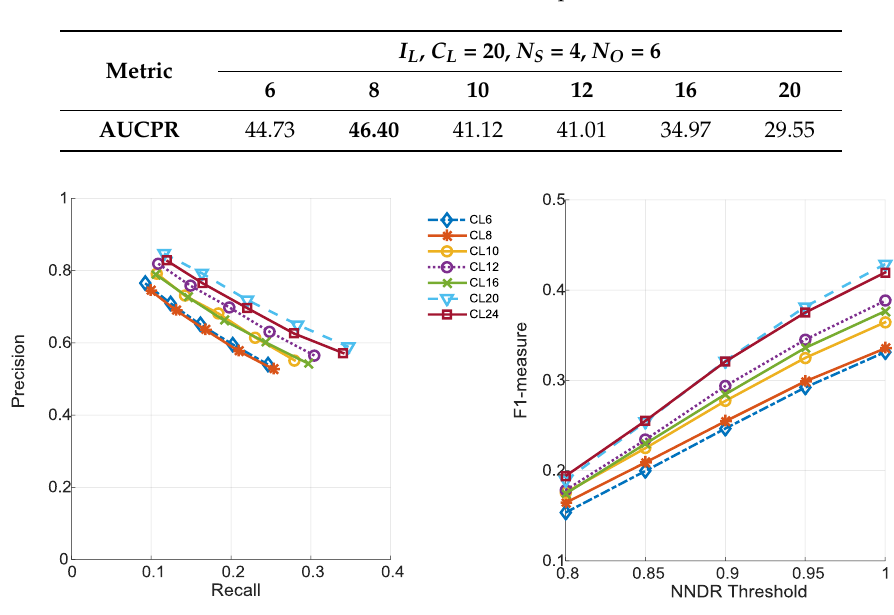
Figure 9. The average PR curve and F1-measure curve results of parameter C L ( I L = 8).